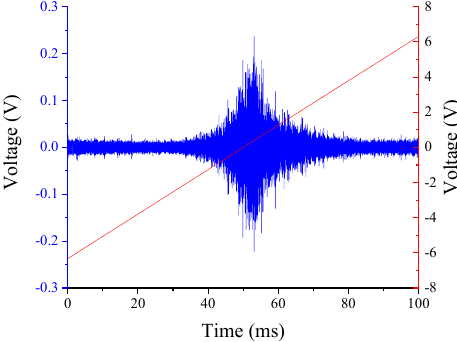
Figure 3. Magnetic Barkhausen noise (MBN) measurement systems.